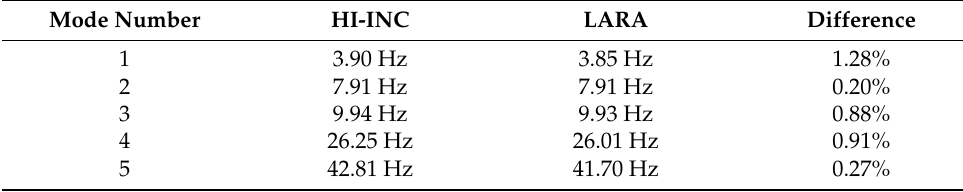
Table 4. Comparison of the first three mode steps frequencies of LARA with